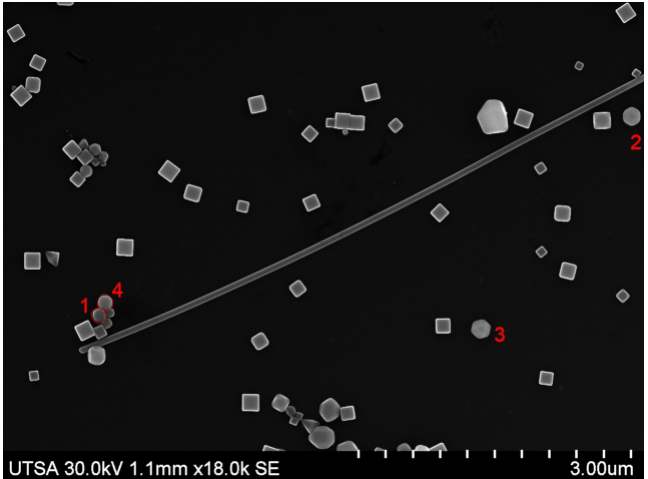
Figure 4. An example of an original SEM micrograph of Ag nanocubes and quasi-spheres, among other structures, from which templates of both morphologies were